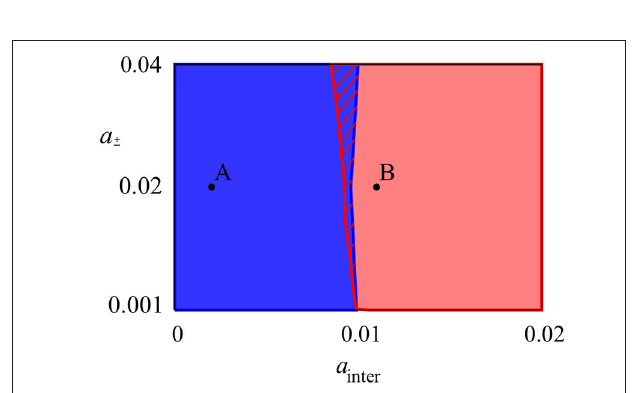
FIGURE 4 | Diagram in the plane of inter-layer a inter and intra-layer a coupling constants for a two-layer system of N = 48 oscillators in each layer with R 1 = R 2 = 16. The red region corresponds to the successful stabilization of chimera states in both layers, the blue region depicts chimera collapse in the uncontrolled layer. In the hatched region only part of the numerical realizations indicated successful control. Points A and B denote parameter values corresponding to Figures 2 and 3 , respectively. Other parameters as in Figure 2